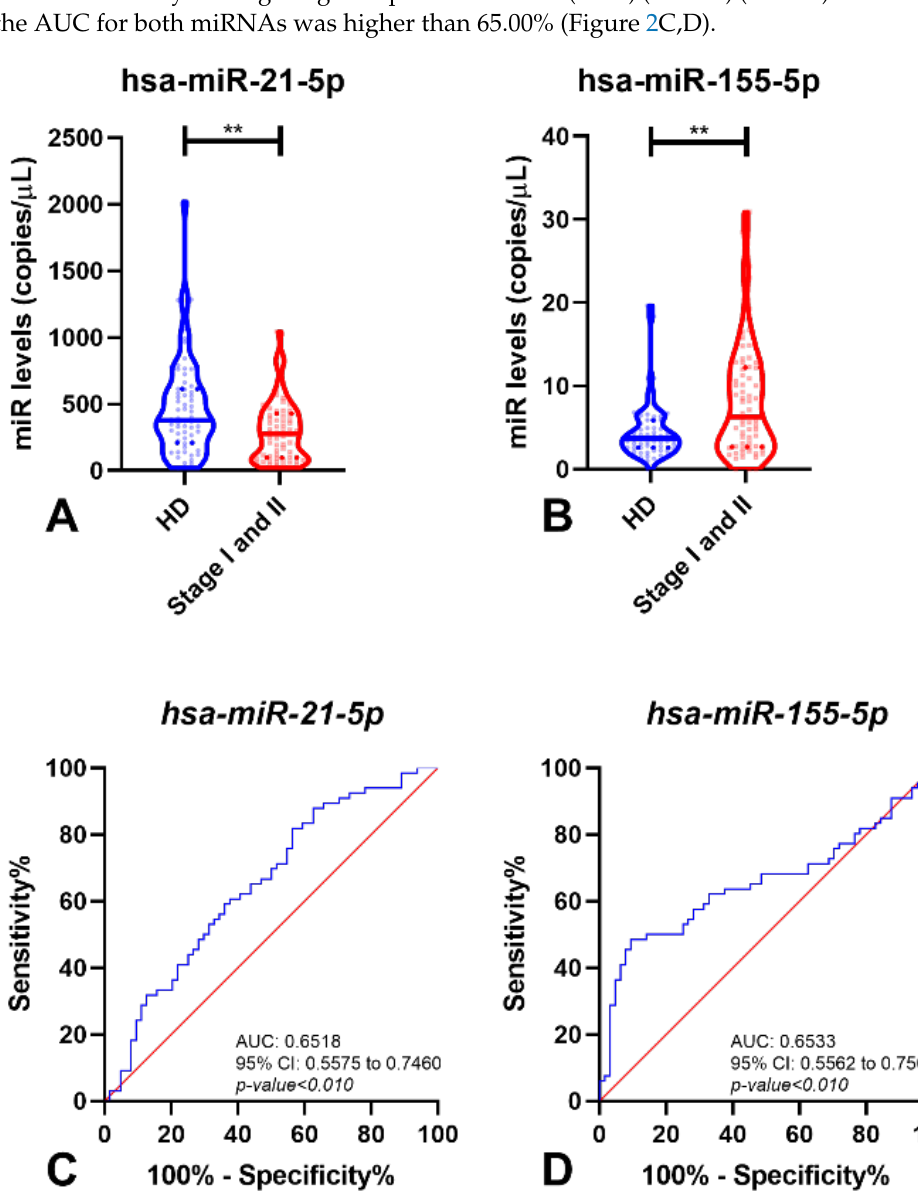
Figure 2. Violin plots of miRNAs levels in Healthy Donor (HD) and early stages of Renal Cell Carcinoma (Stage I and II) samples of hsa-miR-21-5p ( A ) and hsa-miR-155-5p ( B ), and respective Receiver-Operating Characteristic Curve (without resampling analysis) ( C , D ). In violin plots, dashed lines indicate the interquartile range and horizontal line the median of miR levels. In ROC curves, red line indicates the reference line and blue line the identity line for each miRNA. Abbreviations: